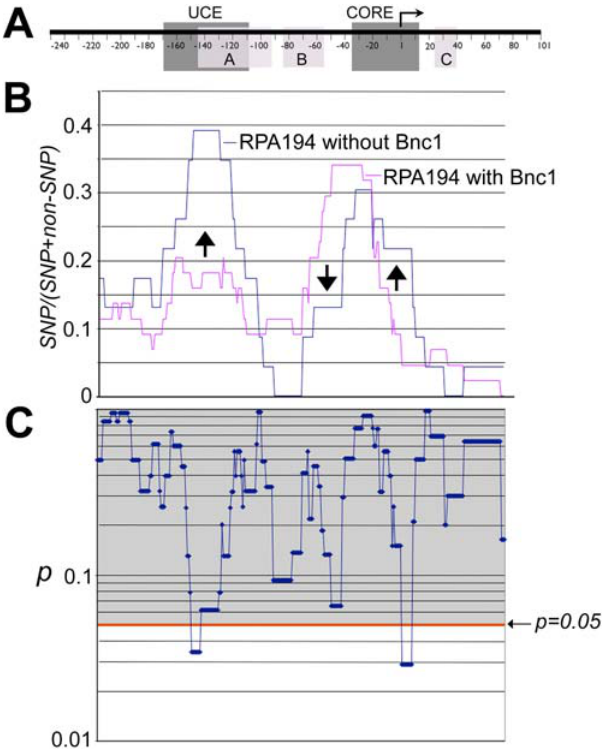
Figure 8. A comparison of RPA194-associated promoters in the presence and absence of basonuclin. A , A generic rDNA promoter is depicted as described in Fig. 5 . B , SNP frequencies of RPA194- associated promoters are plotted as described in Fig. 5 . Arrows show the region as well as the direction of changes caused by basonuclin- deficiency. C , Pair-wise chi-square tests on SNP frequencies shown in B were performed. The resulting p values are plotted in alignment with panels in A and B . The notations are as described in Fig. 4 and 5